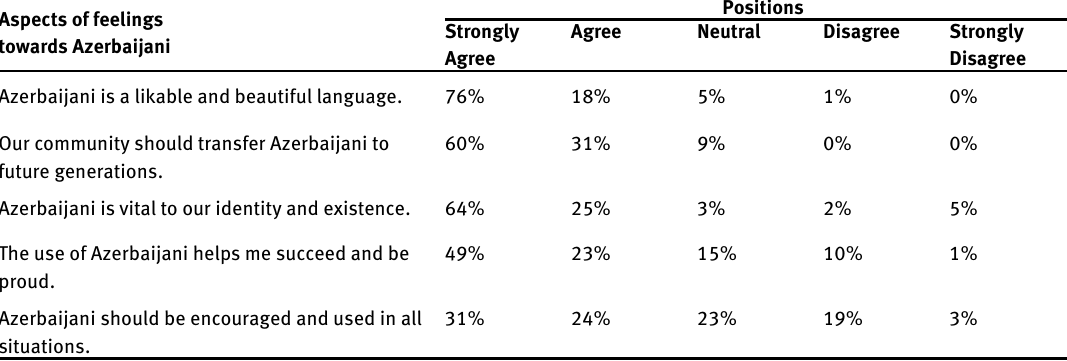
Positions Strongly Agree Neutral Disagree Strongly Agree Disagree